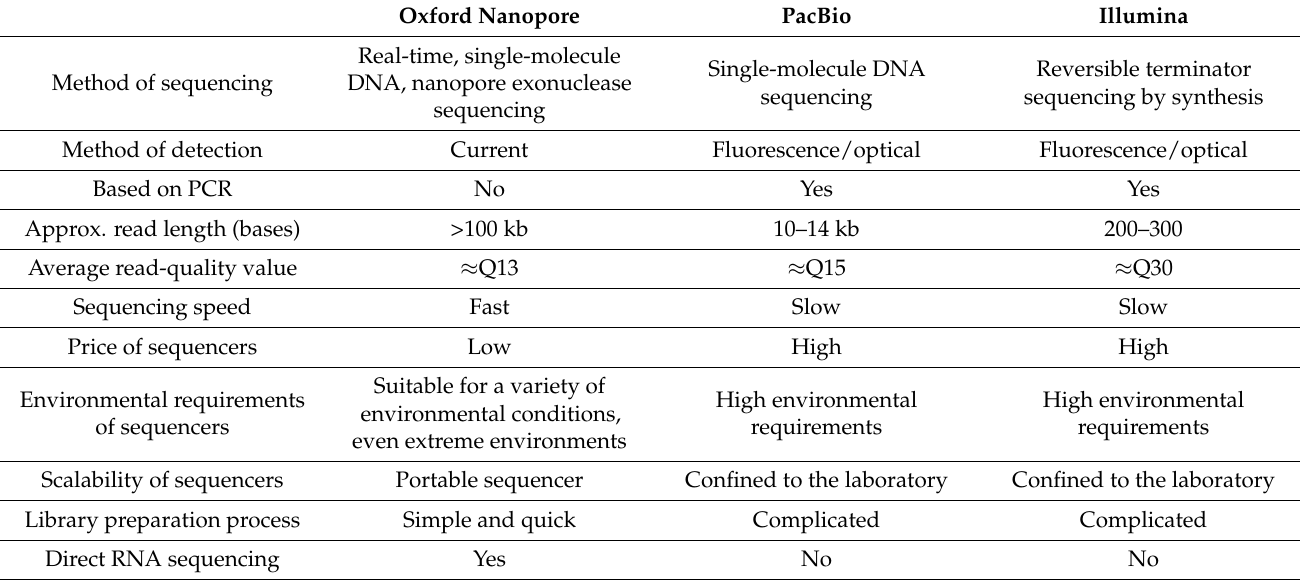
Table 8. Comparison of different sequencing